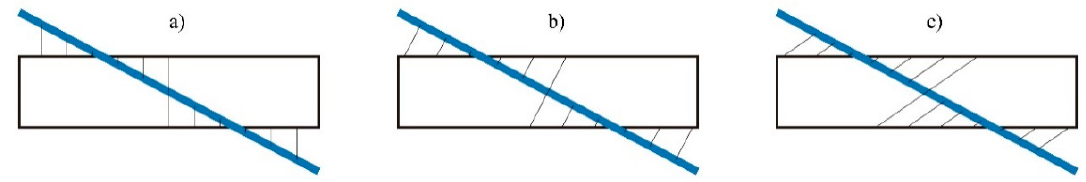
Figure 38. Hangers’ plan layout. ( a ) Perpendicular to deck, ( b ) perpendicular to arch, and ( c ) intermediate case.